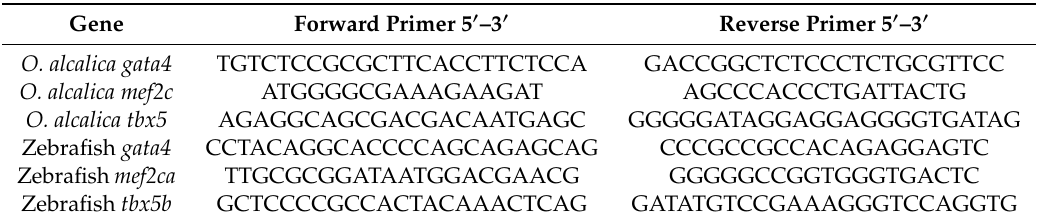
Table 1. Oreochromis (Alcolapia) alcalica and zebrafish primers for RT-PCR and probe synthesis. Gene Forward Primer 5 (cid:48) –3 (cid:48) Reverse Primer 5 (cid:48) –3